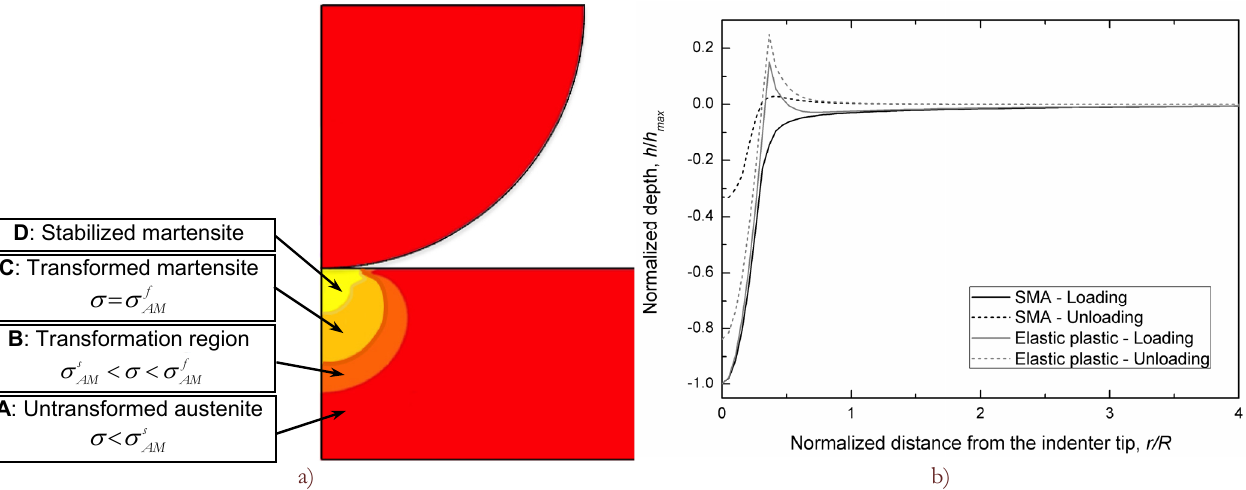
Figure 3: Preliminary FE results: a) stress-induced transformation contours near the contact region; b) comparison of the indentation profile between an elastic-plastic material and a